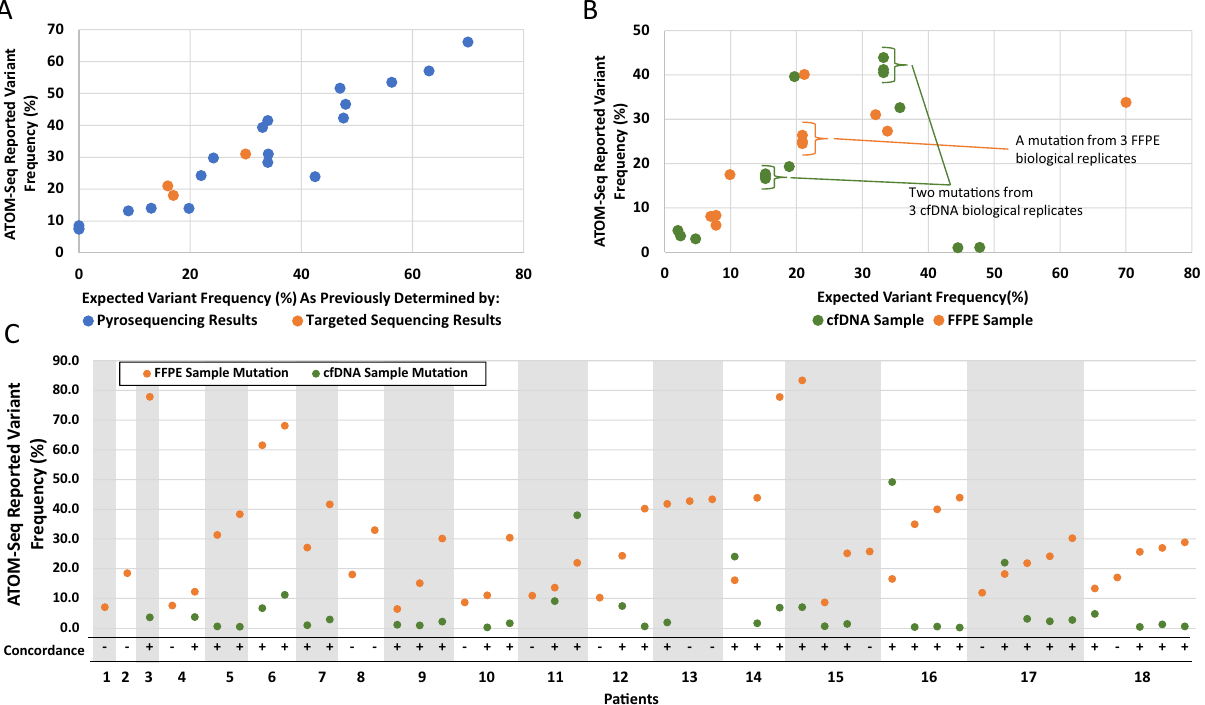
Figure 3. Technical validation of ATOM-Seq on clinical samples. ( A ) Colon cancer samples. Correlation of the allele frequencies reported by ATOM-Seq relative to those determined either by pyrosequencing (blue spots) or targeted sequencing (orange spots). ATOM-Seq showed superior sensitivity by detecting variants in two samples which were not found when analysed by pyrosequencing as these were below the technology’s minimum sensitivity. ( B ) Lung cancer samples. Correlation of the allele frequencies reported by ATOM-Seq relative to those determined by an alternative NGS approach. ( C ) Paired lung cancer samples. Details of the allele frequencies for mutations found in FFPE samples and the concordant mutations from a matched cfDNA sample. A total of 84% (15/18) of patients had concordant mutations